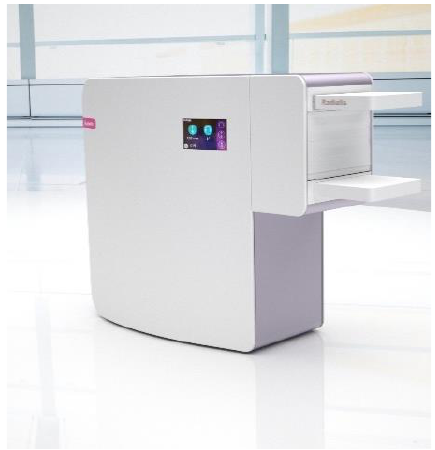
Figure 1. Configuration of the Radialis PET Camera with two planar detector heads to be positioned on either side of a breast.